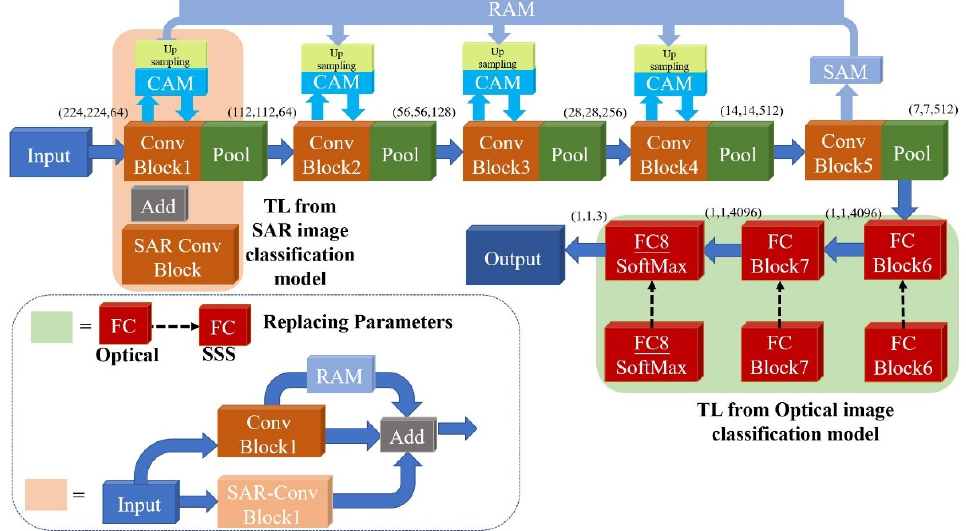
Figure 6. Architecture diagram of proposed MDCTL-MSRAM network.